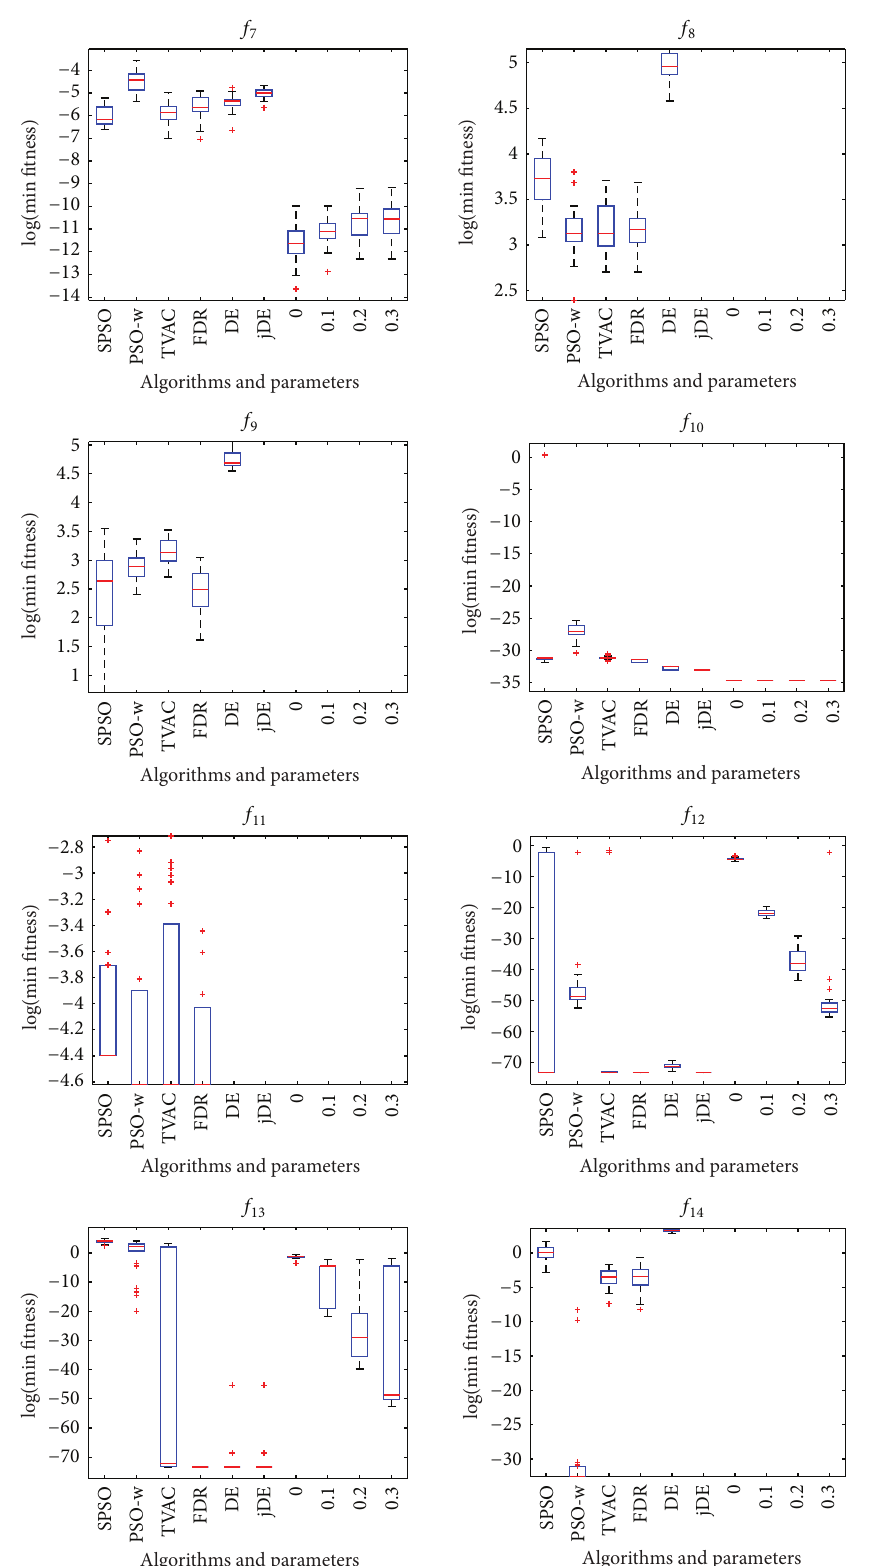
Figure 5: HPSO-DE with different balance parameters and other six algorithms on 𝑓 7 , 𝑓 8 , 𝑓 9 , 𝑓 10 , 𝑓 11 , 𝑓 12 , 𝑓 13 , and 𝑓 14